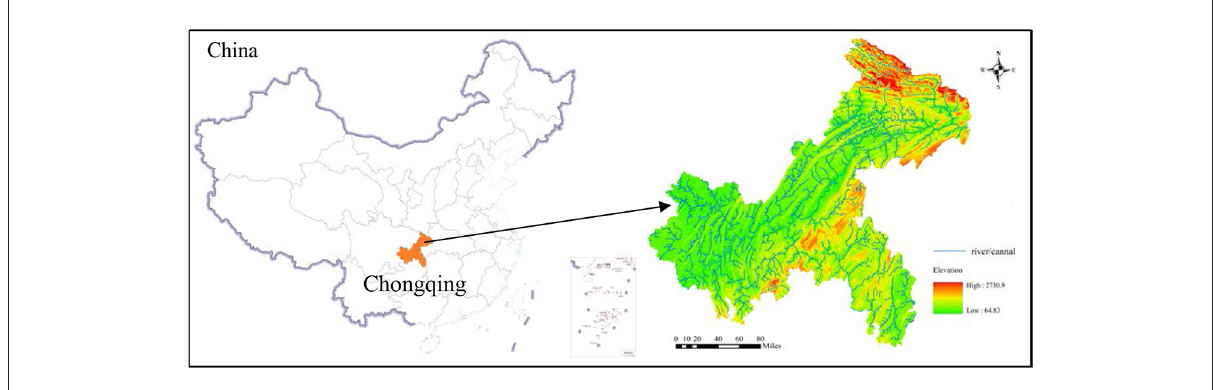
FIGURE1 The location of study